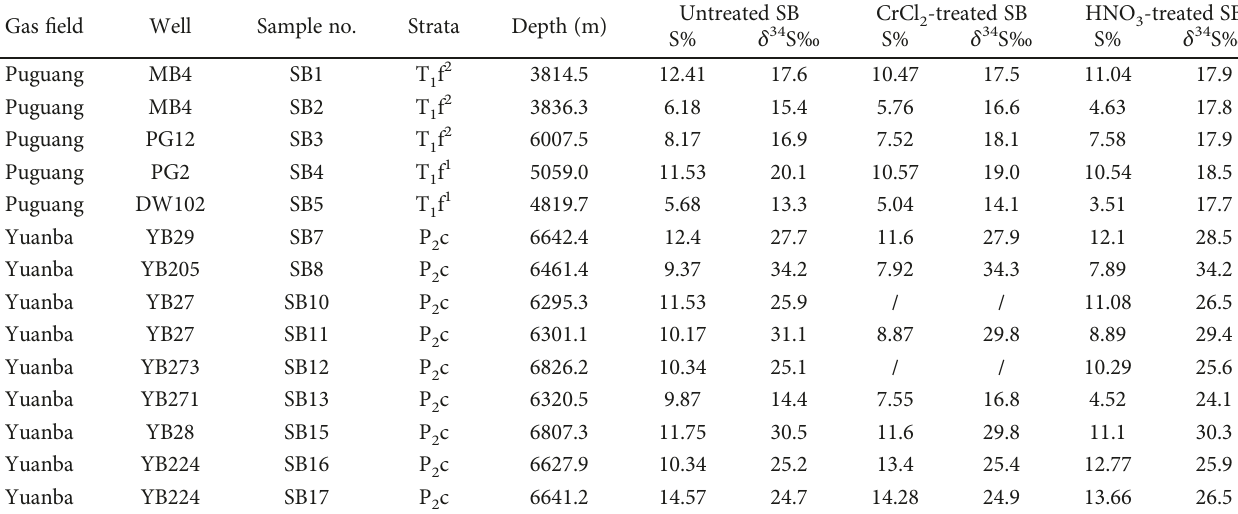
Table 1: Sulfur content and isotope composition of solid bitumen from the Yuanba and Puguang gas fi elds in the Sichuan Basin. Gas fi eld Well Sample no. Strata Depth (m)